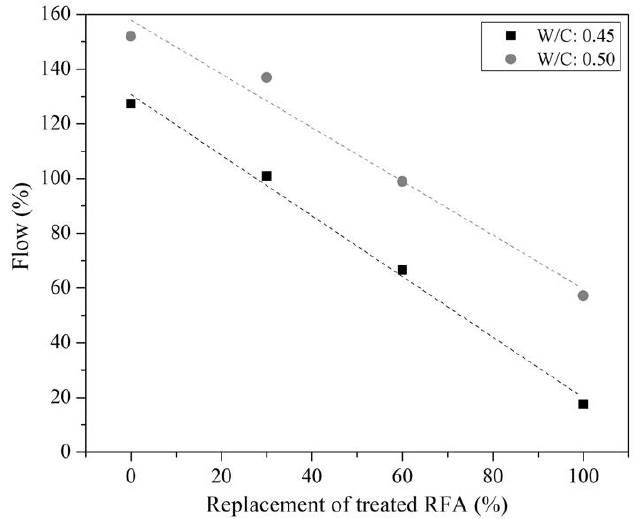
Figure 11. Flow of mortar mixes with different replacement of treated RFA at 0.5mol/L – 7d – 20ºC.